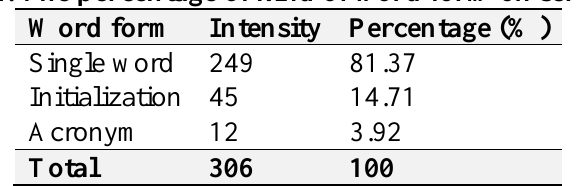
Table 2. The percentage of kind of word form on scribbling